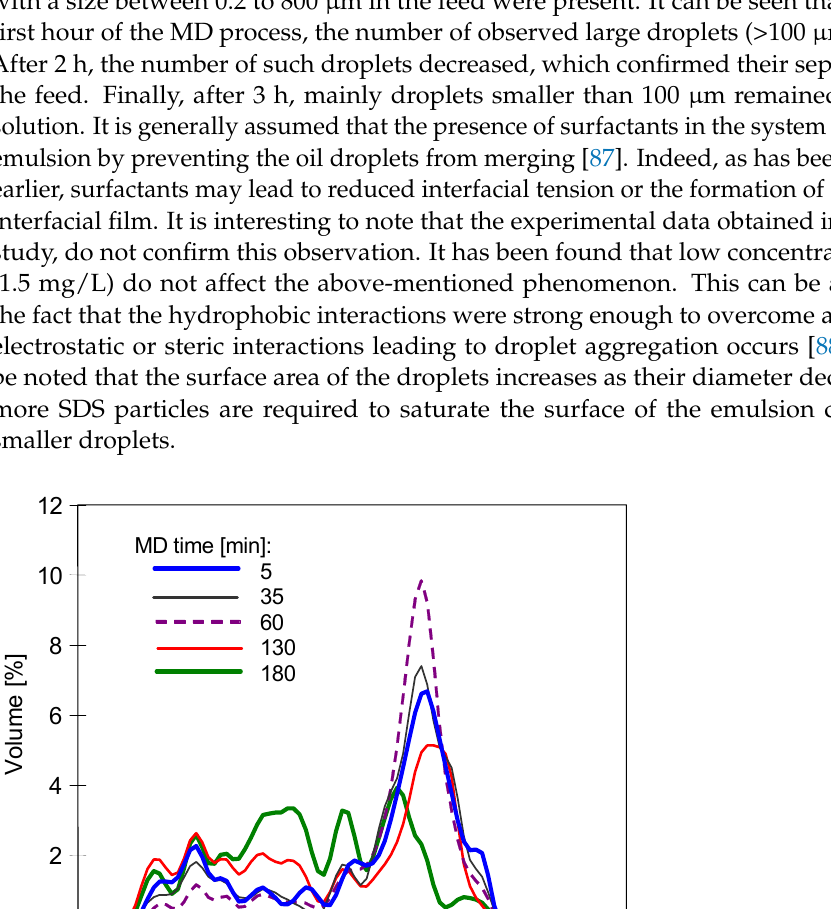
feed was decreasing, hence, a new portion of the emulsion was periodically added to the